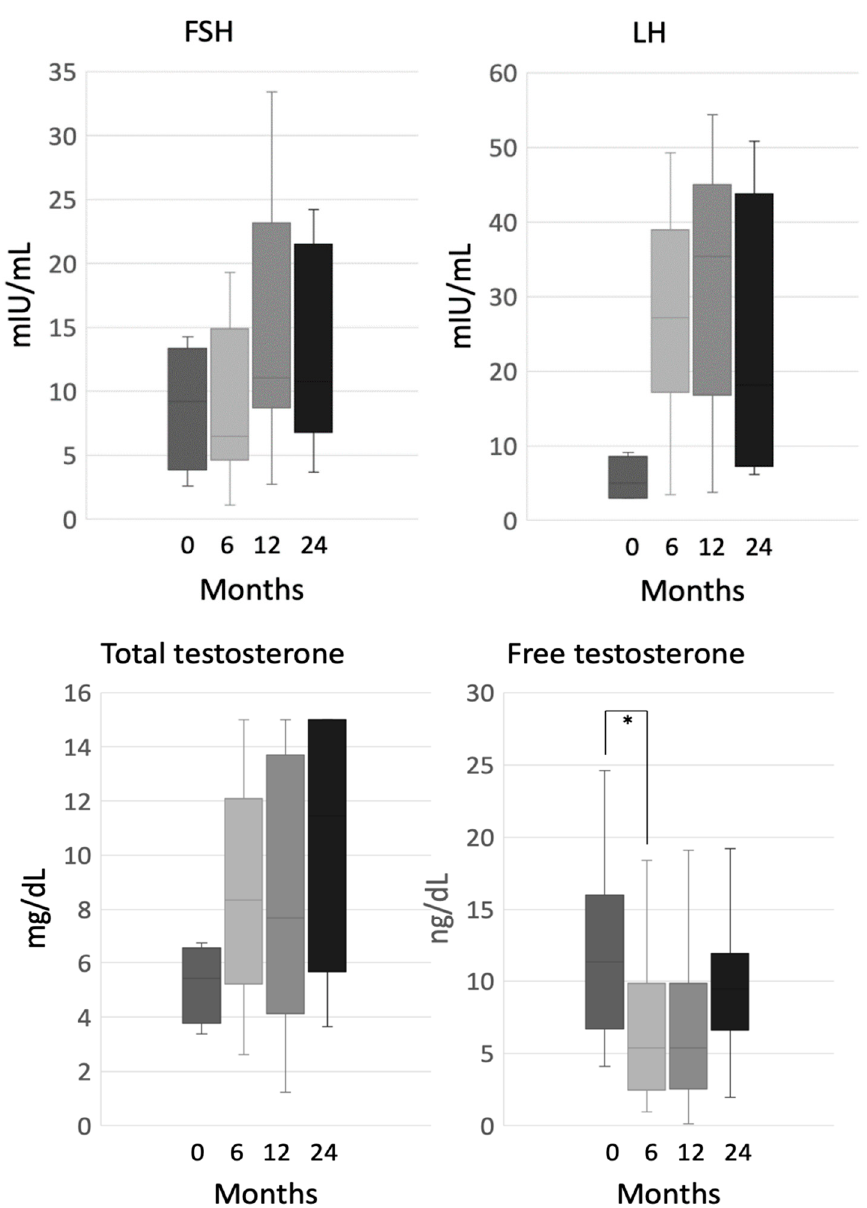
Figure 4. Follicle-stimulating hormone (FSH), luteinizing hormone (LH), total and free testosterone during mitotane therapy in male patients; * indicates statistical significance, Note: patients who were put on testosterone replacement were excluded from the analysis.